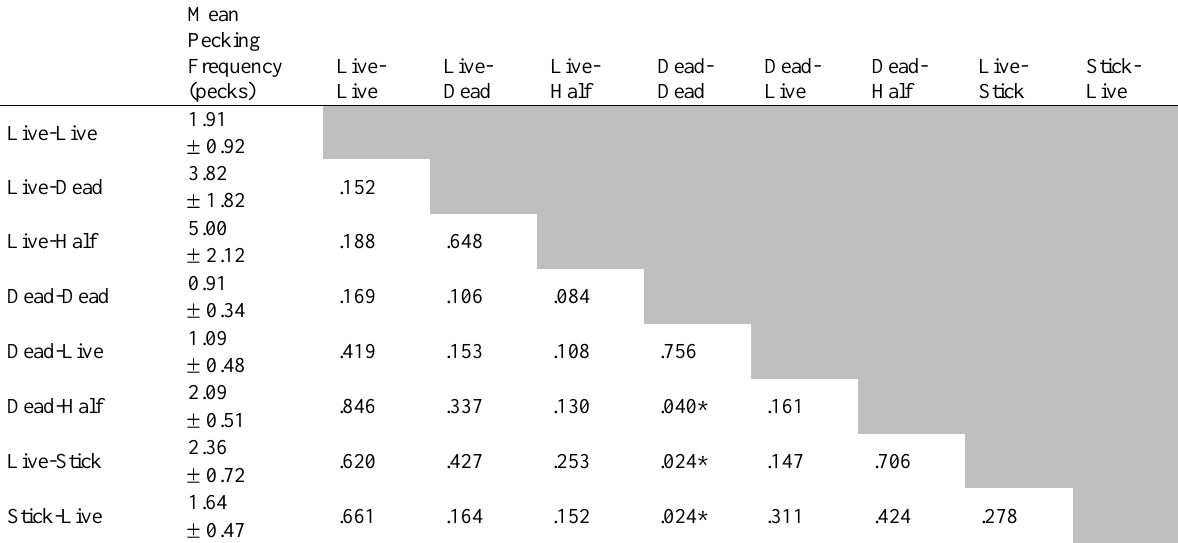
Experiment 2: Pecking Frequency Mean and Significance (p-values) Between Conditions